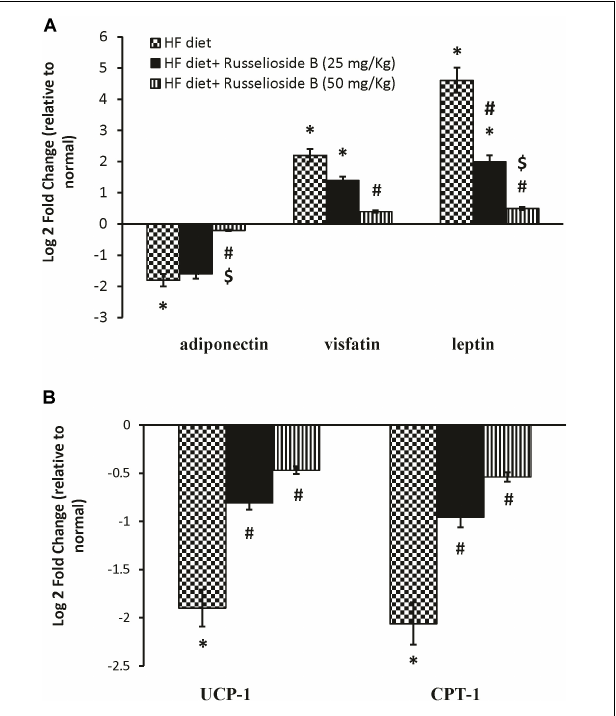
FIGURE 3 | Effect of russelioside B on the mRNA expression of adipokines and energy expenditure genes in adipose tissue using quantitative real-time PCR. (A) Gene expression of adiponectin, visfatin, and leptin in white adipose tissue; (B) gene expression of mitochondrial uncoupling protein-1 (UCP-1) and carnitine palmitoyl transferase 1 (CPT-1) in brown adipose tissue. Data are expressed as log2 fold change relative to the normal group. Negative values indicate downregulation. Bars correspond to standard error. ∗ significant versus normal group, # significant versus HF diet control group, and $ significant versus HF diet + russelioside B (25 mg/kg) group. Comparison was done by one-way ANOVA followed by Bonferroni’s test at P <